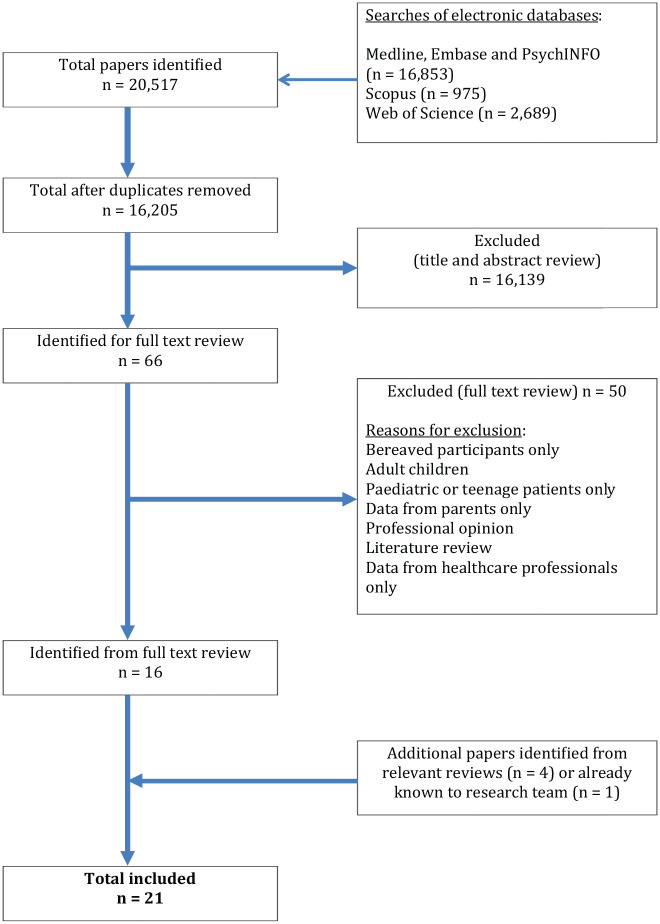
PRISMA flow diagram.